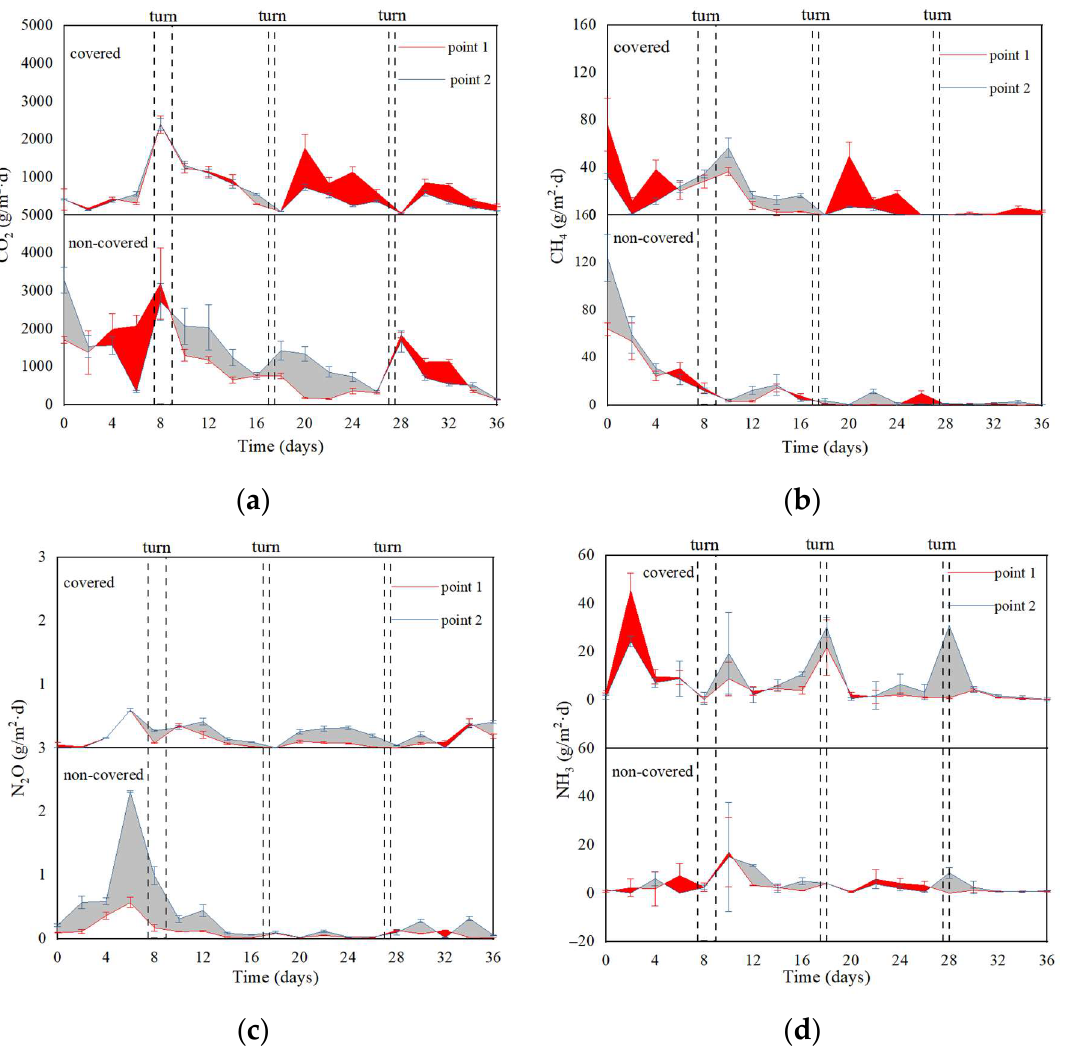
Figure 5. Dynamic changes of CO 2 ( a ), CH 4 ( b ), N 2 O ( c ), and NH 3 ( d ) at different monitoring points during aerobic composting.